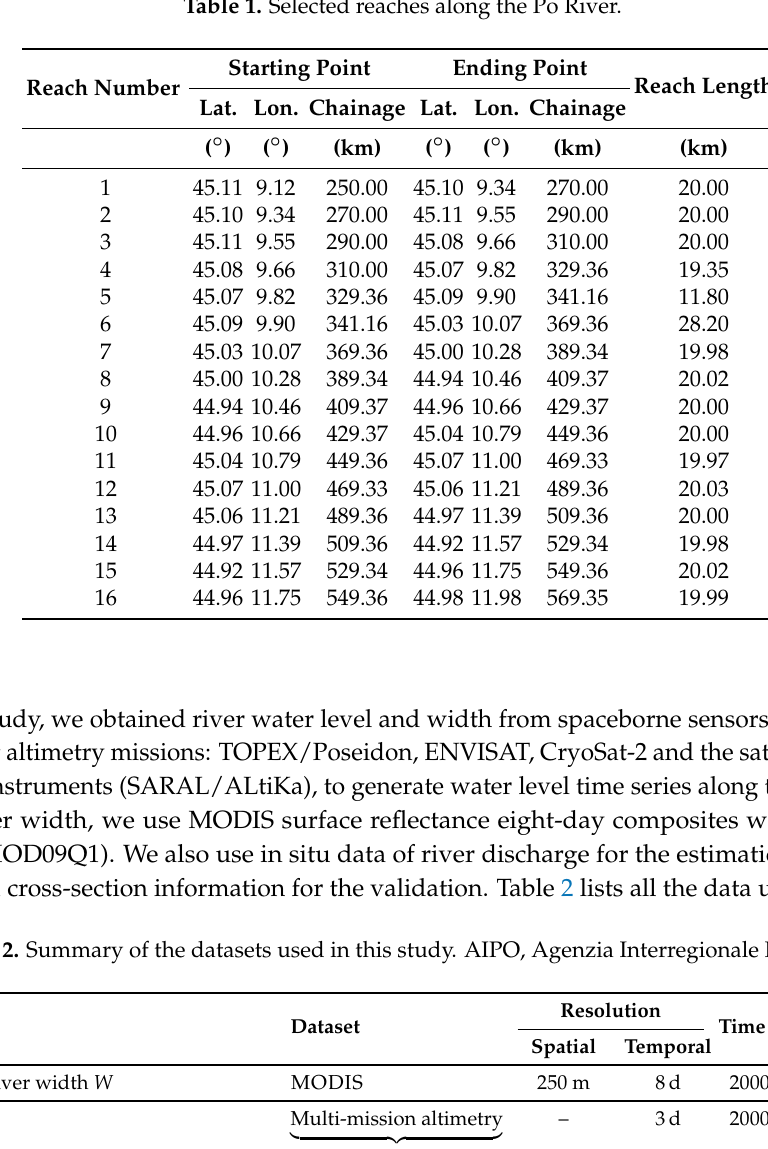
Table 1. Selected reaches along the Po River.